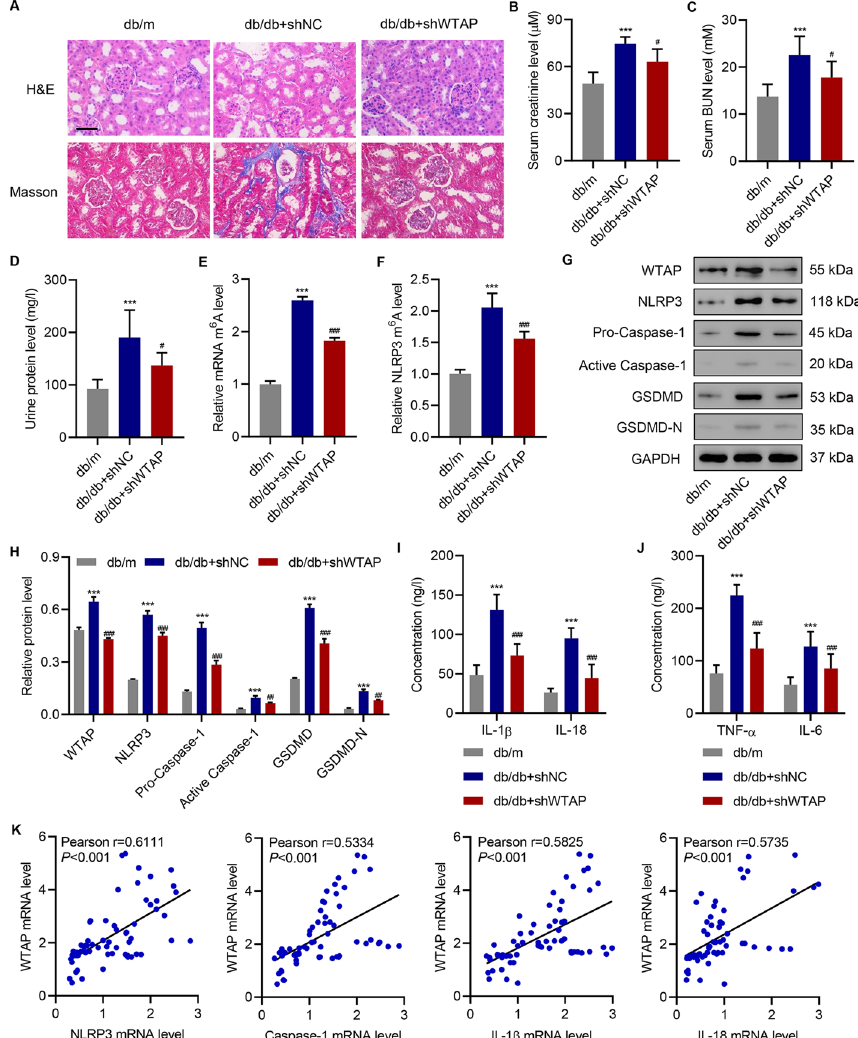
Fig. 6 WTAP knockdown inhibits cell pyroptosis and pro-inflammatory factor release in db/db mice. A H&E and Masson’s trichrome staining of mouse kidney tissues ( n serum blood urea nitrogen, and urine protein levels (